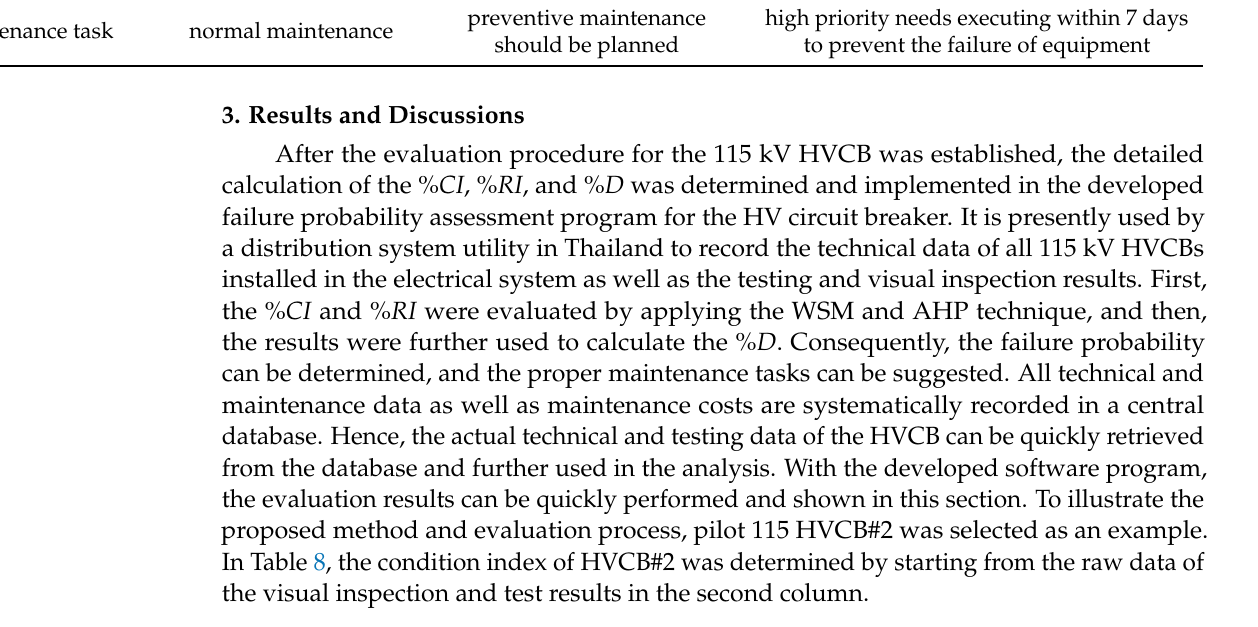
Table 8. Condition index determination of HVCB#2 by using its actual data and test